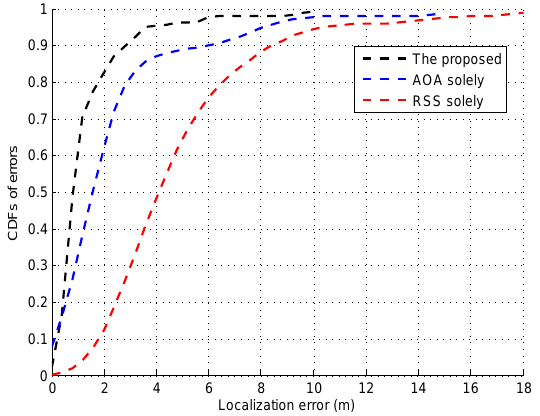
Figure 21. CDFs of errors by using the proposed system and the ones using the AOA or RSS